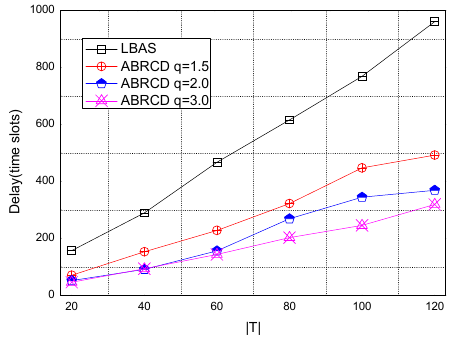
Figure 41. The impact of | T | with fixed network size = 800 on delay. Sensors 2018 , 18 , x FOR PEER REVIEW